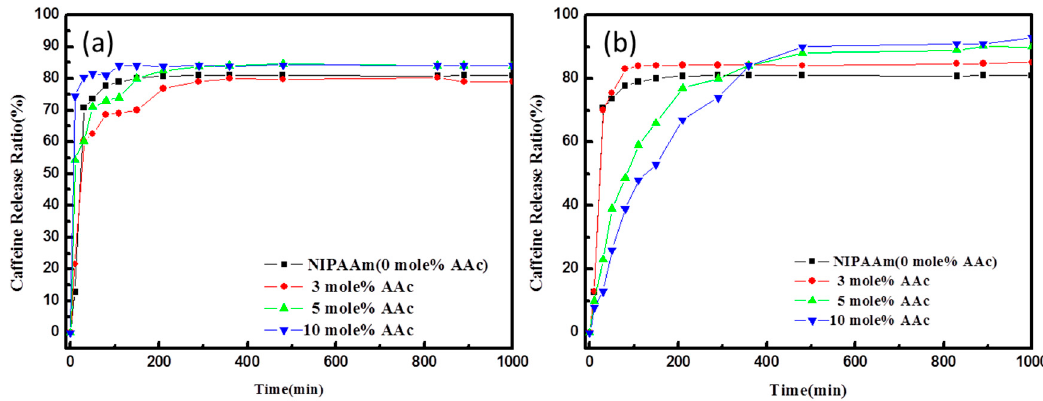
Figure 8. The caffeine drug release curves of different composite hydrogels tested at a temperature of 37°C of PBS and at ( a ) pH = 4, ( b ) pH = 10.